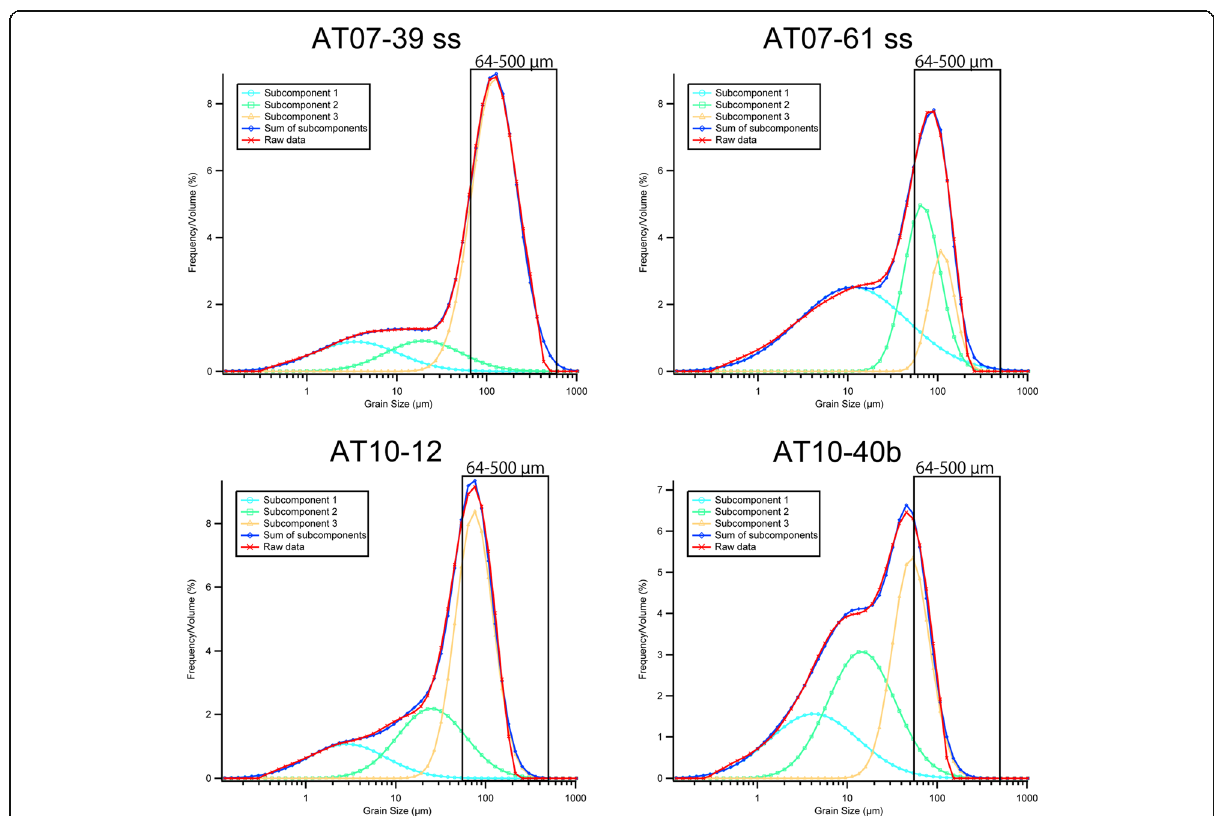
Fig. 3 Typical grain size distributions of representative samples. Measured data is indicated in red, and the three identified sub-components are indicated in blue, yellow, and green. The 64 – 500 μ m fraction used for the ESR and CI analyses in this study corresponds to the coarsest